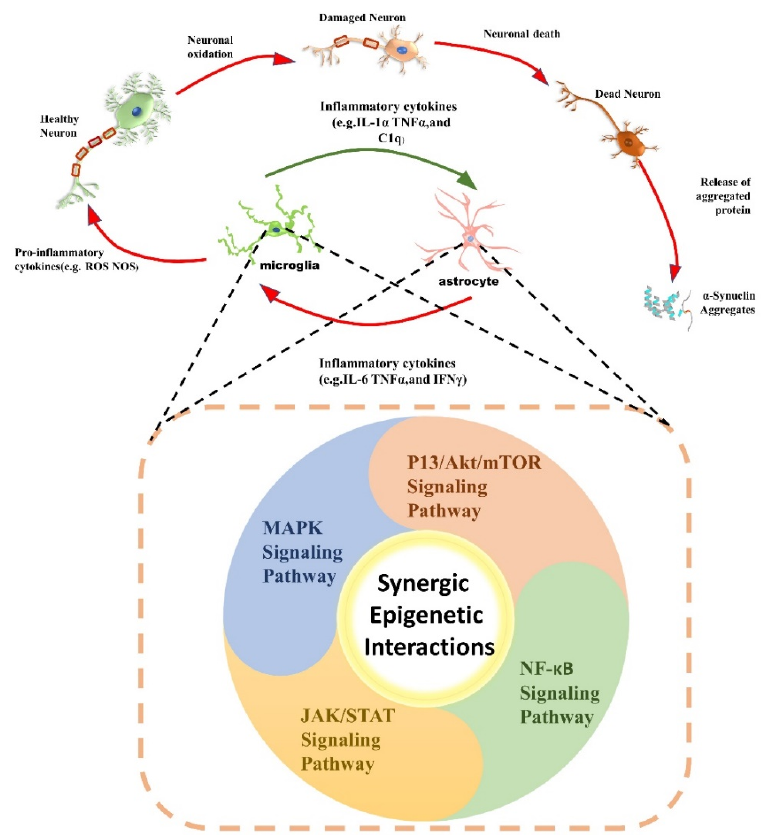
Figure 2. An overview of synergic epigenetic interactions with neuroinflammatory pathways in PD development. Various epigenetic mechanisms synergistically interact with each other and with inflammatory pathways (MAPK signaling pathway, P13K/Akt/mTOR signaling pathway, JAK/STAT signaling pathway, and NF ‐κ B signaling pathway) to feedforward neuroinflammation in Parkinson’s disease. These neuroinflammatory pathways activate microglia and astrocytes and release inflammatory cytokines. Overactivation of microglia and astrocytes triggers the release of pro ‐ inflammatory cytokines, which further damages normal dopamine neurons, leading to neuronal apoptosis and α‐ synuclein aggregation. Altogether, these synergic interactions form a vicious cycle that further exaggerates neuroinflammation to hallmark parkinsonism.